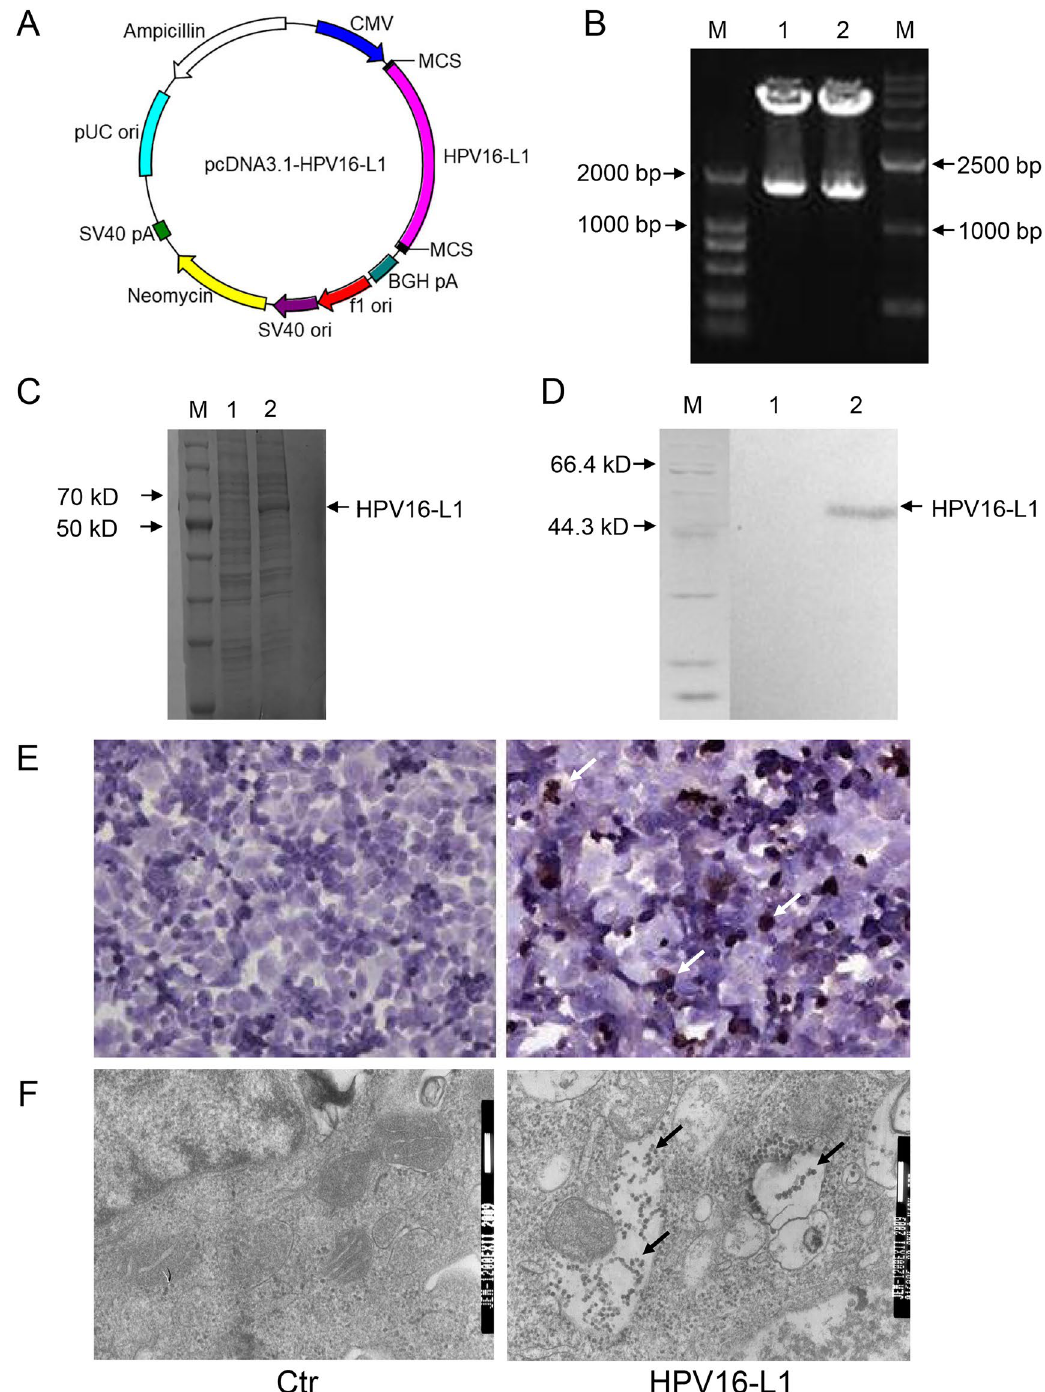
Figure 1. The pcDNA3.1-HPV16-L1 plasmid was successfully constructed and HPV16-L1 was identified to express in BHK cells. ( A ) The map of pcDNA3.1-HPV16-L1. ( B ) Identification of pcDNA3.1-HPV16-L1 by restriction enzyme digestion. (M1: DL2 000; lane 12: plasmid digested by HindIII and KpnI; M2: DL15000). ( C ) SDS PAGE analysis of HPV16-L1 protein expressed in BHK cells (M: protein marker, lane 1: control, lane 2: expressed protein). ( D ) Western blotting analysis of HPV16-L1 protein expressed in BHK cells (M: protein marker; lane 1: control; lane 2: expressed protein). ( E ) Immunocytochemistry analysis of HPV16-L1 protein expressed in BHK(× 400). ( F ) Electron microscropy detection of HPV16-L1 expressed in BHK